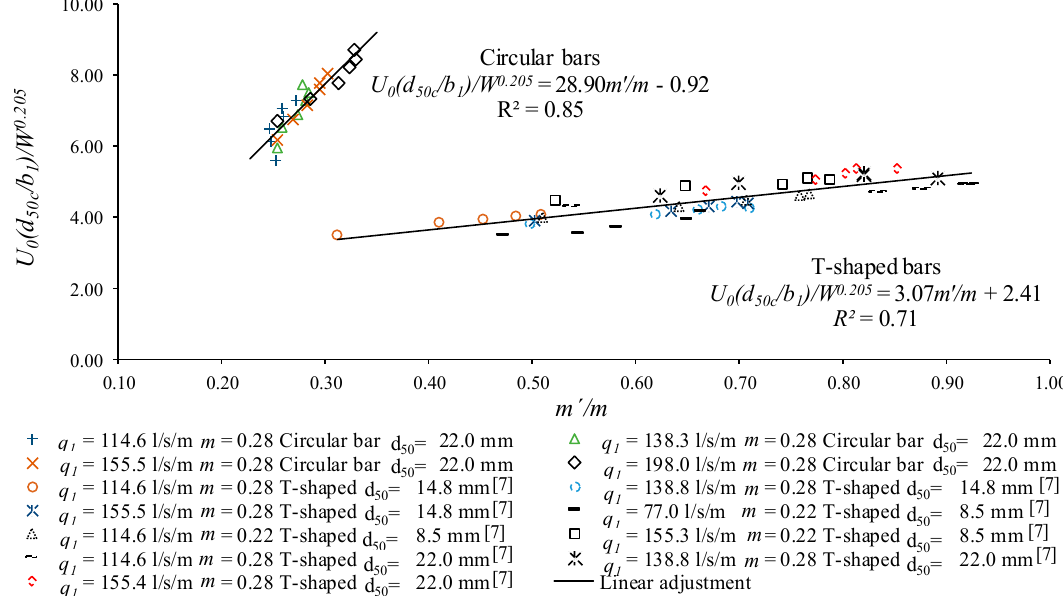
Figure 19. Linear adjustment of the ratio m ′ /m ratio as a function of the values U 0 , d 50 c /b 1 , and W .